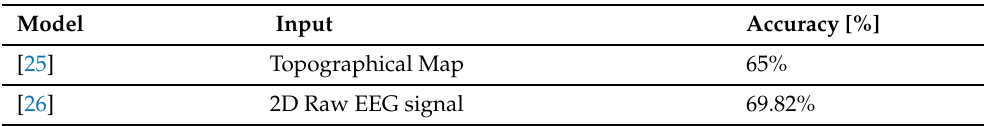
Figure 22. Results of 3D raw EEG signal representation with the 2D CNN models. The pink dashed line indicates results reported in [25]. The purple dashed line indicates results reported in [26]. Table 4. Raw EEG signal as volume representation results. It can be observed that the results show a significant improvement in comparison to those from the vertically stacked spectrograms. Similar to the 2D raw EEG inputs, the best results are observed within the 9- and 5-channel selections. Through this EEG representation, the single-layer CNN model returned a classification accuracy of 63.70% and 62.64% with the 9- and 5-channel selections respectively. For the two-layer CNN model, 9- and 5-channel selections delivered results that outperformed the state of the art, with a classification accuracy of 73.93% for the 9-channel selection and 69.84% for the 5-channel selection. Lastly, the three- layer CNN model was only able to outperform the results presented by [25], with an accuracy of 68.35% and 67.37% for the 9- and 5-channel selection respectively. Best results that outperformed the state of the art are highlighted in